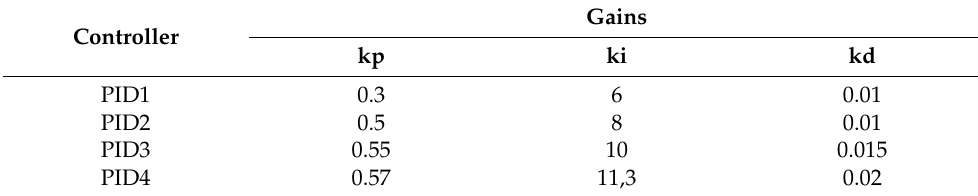
Figure 23. Block diagram of closed-loop control system with direct hysteresis compensation by the inverse model. Table 5. PID controller gains.